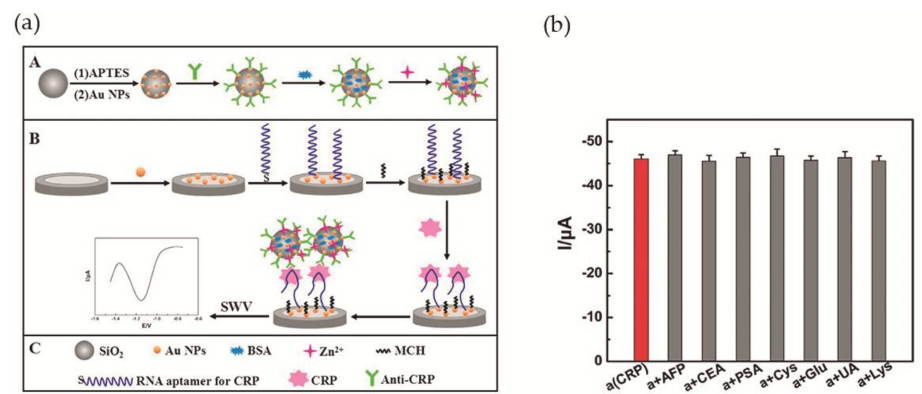
Figure 7. ( a ) Illustration of the assembled CRP aptasensor. A—Modification of Si MSs with Au NPs, anti-CRP, BSA and zinc ions. B—Modification of bare GCE with Au NPs, RNA aptamer and 6-mercapto-1-hexanol (MCH). Aptasensor detecting CRP and square wave voltammetry (SWV) record of the signal; ( b ) Changes in peak current during CRP detection in the presence of interfering compounds. Reproduced with permission from ref. [56]. Copyright Elsevier B. V.,